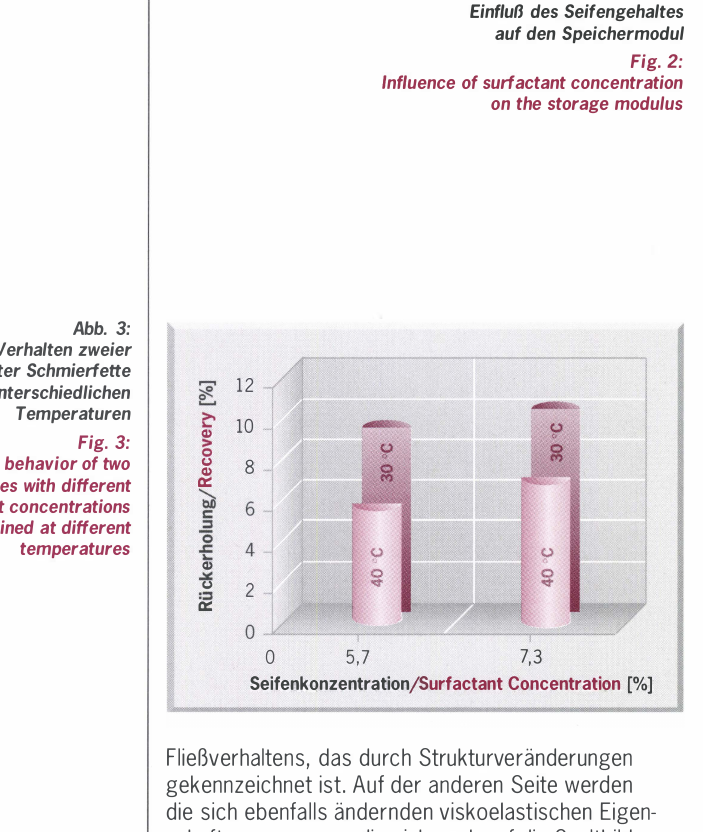
Fig. 2: Influence of surfactant concentration on the storage